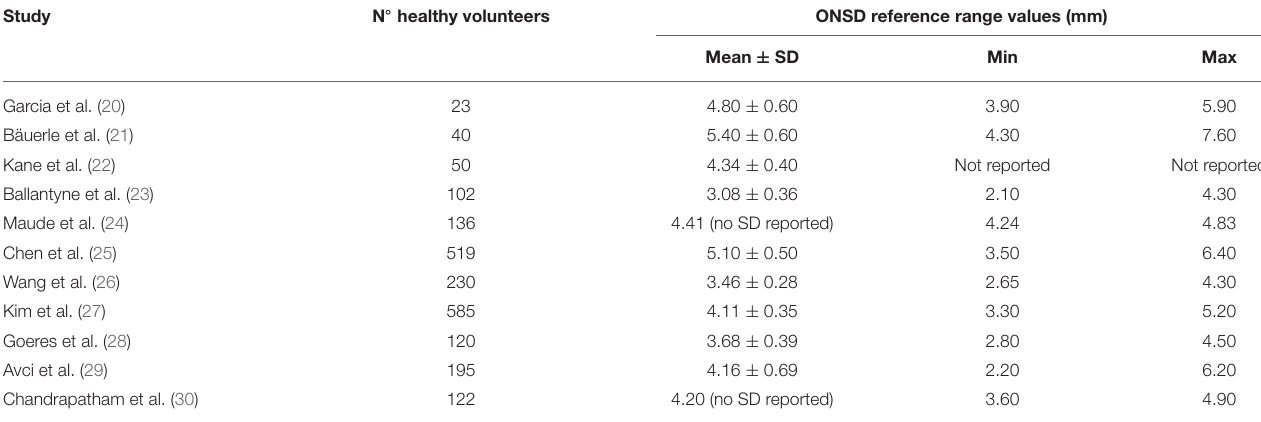
TABLE 2 | Summary of the optic nerve sheath diameter ultrasound reference range values established in studies on healthy people.